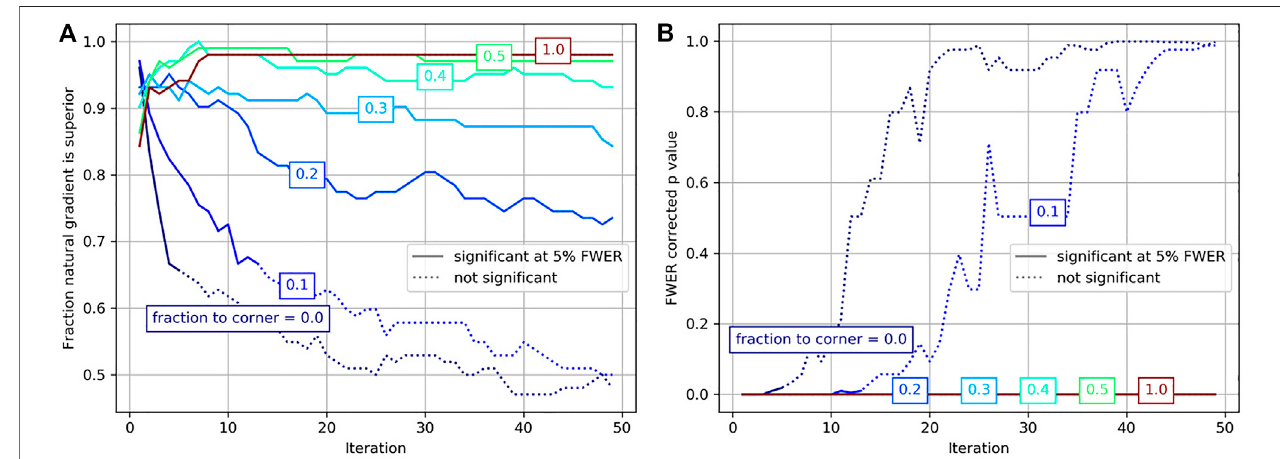
FIGURE7 | Comparison between the alternating minimization and natural gradient methodare shown at each iteration ofoptimization for coordinate origin placed at various fractions of the distance between the center and the corner. (A) shows the fraction of the time the natural gradient method performs the best, with statistically signi fi cant(familywise error ratecorrected p values lessthan 0.05) samplesshown assolid lines. (B) shows thefamilywise error rate p valuesunderthe same